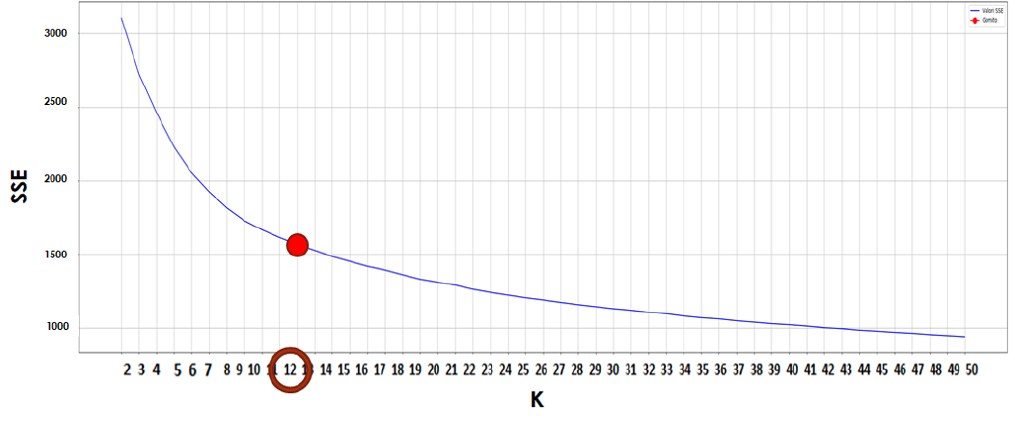
Figure 9. SSE trend against K.